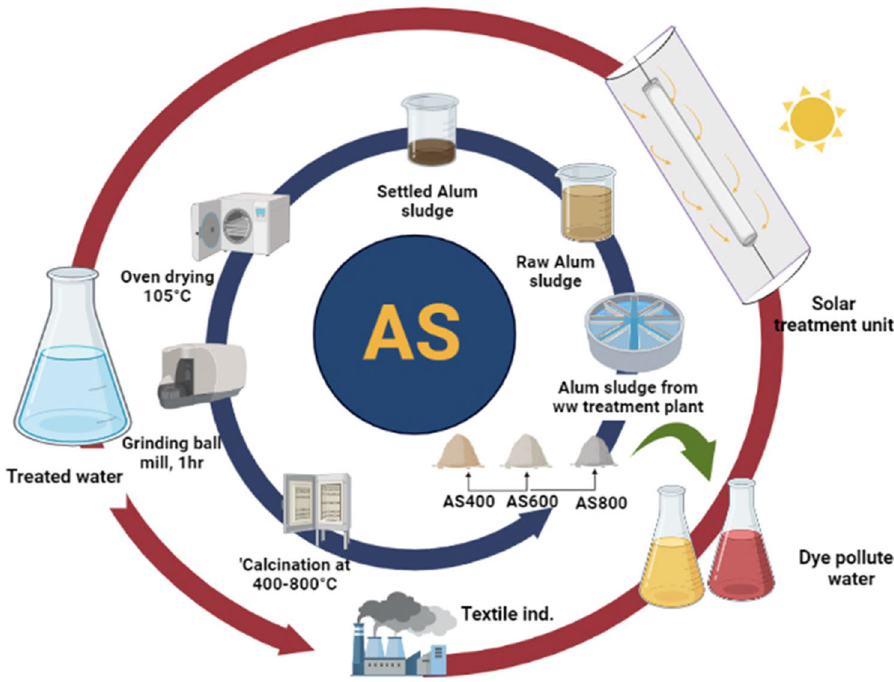
Fig. 1 Graphical Overview of transforming waste alum sludge into Fenton